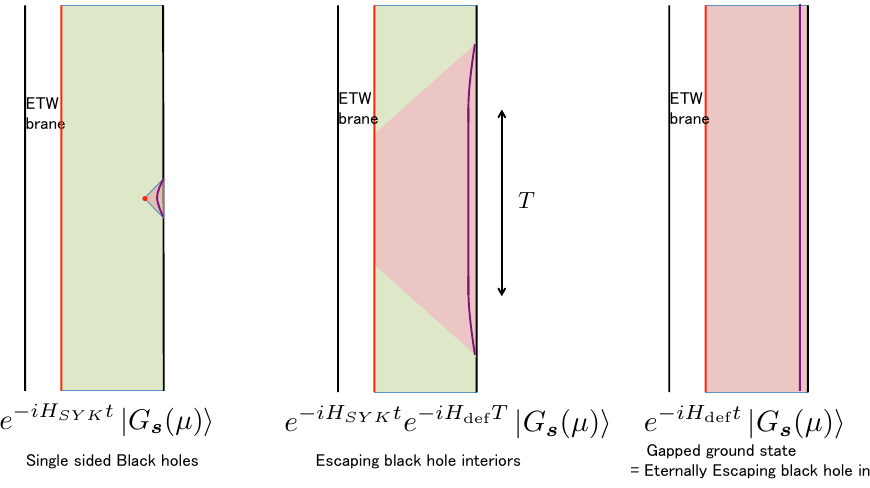
Figure 23 . A gravity interpretation of the escaping interior protocol on the mass deformed ground state. Left: the SYK evolution, which is interpreted as the evolution without any double trace deformation, makes the black hole with EOW branes. We also evolve in backward by the SYK Hamiltonian. Middle: we apply the escaping interior protocol for (cid:12)nite amount of time T and then evolve by the SYK Hamiltonian. This is equivalent to shifting the horizon by insert the global AdS 2 patch. Right: we apply the escaping interior protocol for eternally. As a consequence, the horizons are shifted in(cid:12)nitely away from the original horizon. Finally we recover the global AdS 2 with the EOW